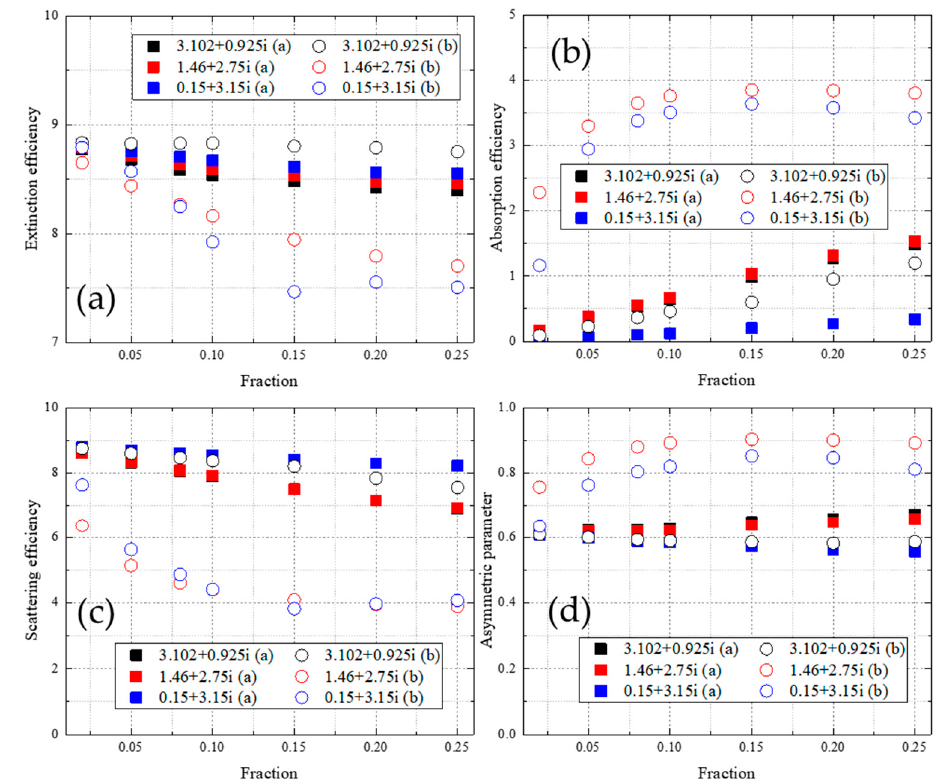
Figure 6. Radiometric properties of the particle aggregate changed with the volume fraction of the minor component of different refractive indices. The particle radius is 2 µ m. (Square symbol: Mode A, with the minor component particles randomly positioned; circle symbol: Mode B; black symbol: minor component m 2 = 3.102 + 0.0925i; red symbol: minor component m 2 = 1.46 + 2.75i; blue symbol: minor component m 2 = 0.15 + 3.15i). ( a ) Extinction efficiency; ( b ) absorption efficiency; ( c ) scattering efficiency; ( d ) asymmetric parameter.